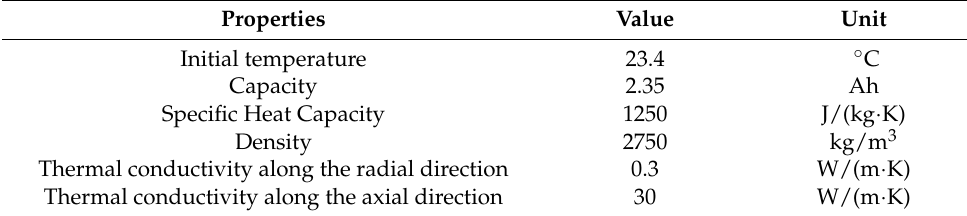
Table 5. Properties of the simulation